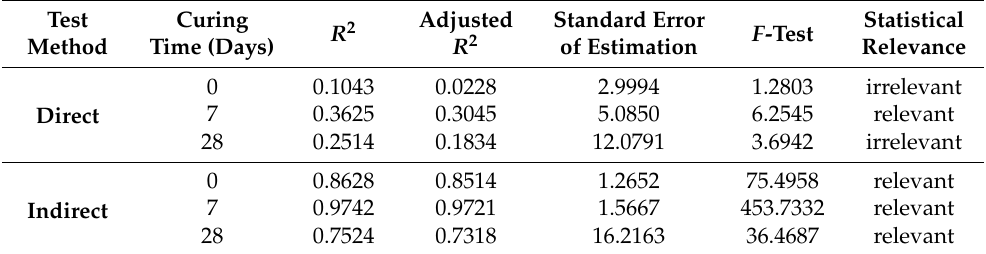
Table 4. Results of the multiple linear regression of the dependence of the tensile strength on the ben- tonite addition (0, 5, 10, 15%) for different curing